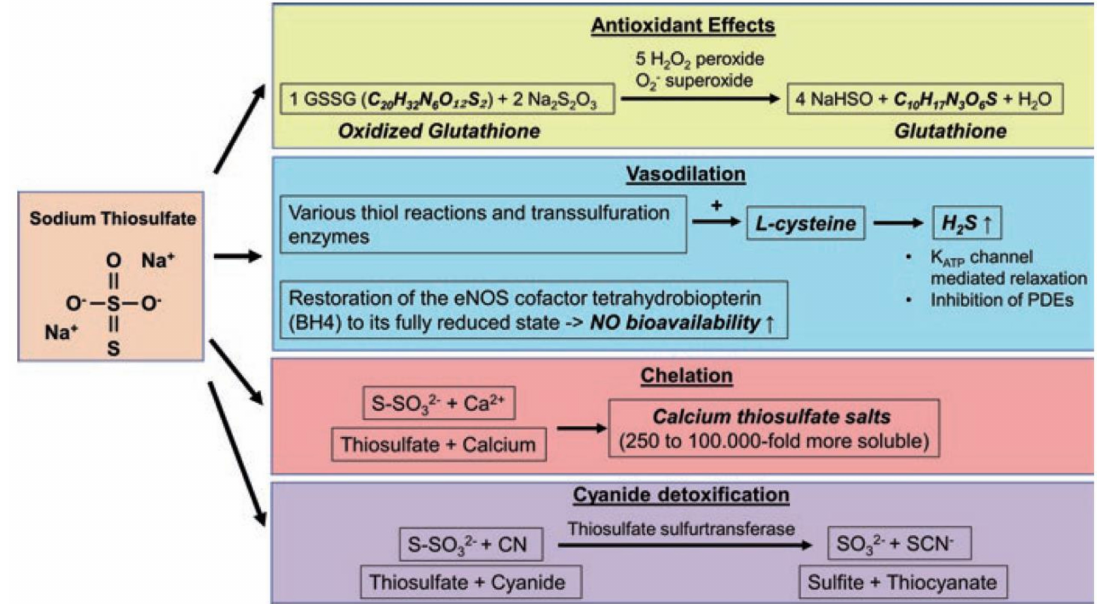
Figure 3. Biochemical effects of sodium thiosulfate. Na 2 S 2 O 3 can reduce oxidized glutathione [34], mediate vaso-dilation [35], work as a calcium chelator [36], and work as an antidote for cyanide [37]. Figure taken from [38]. Copyright 2019 Springer Nature Switzerland AG. Reprinted with